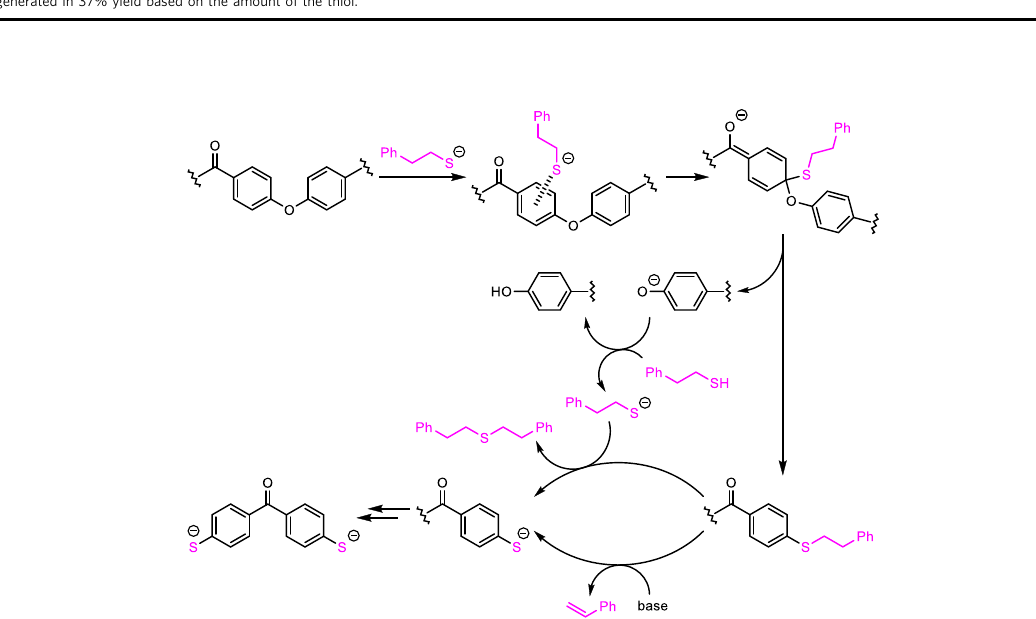
Fig. 5 Proposed depolymerization of PEEK. Cleavage of carbon – oxygen main chains by the alkyl thiolate followed by dealkylation on sulfur to form aryl thiolate generation. Sodium cation is